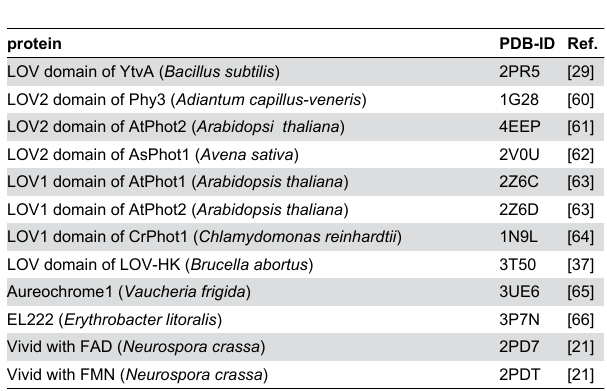
Table 1. Selection of available LOV structures.